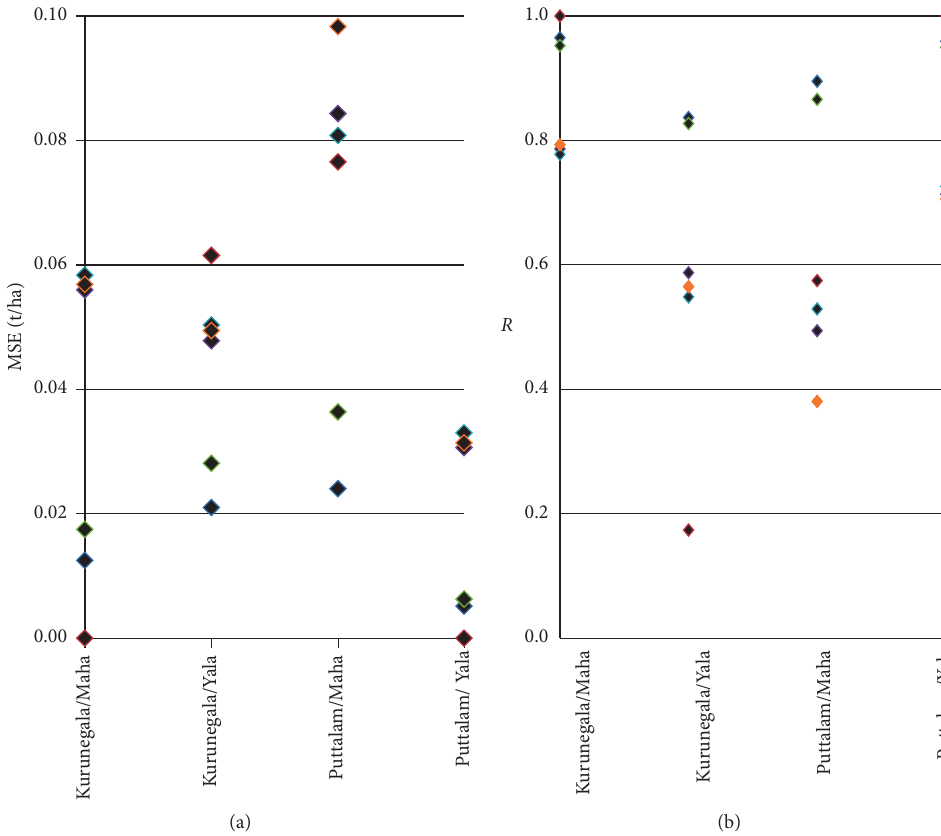
Figure 2: Performance of the models developed separately based on the district and the agricultural season. (a) MSE. (b) R .